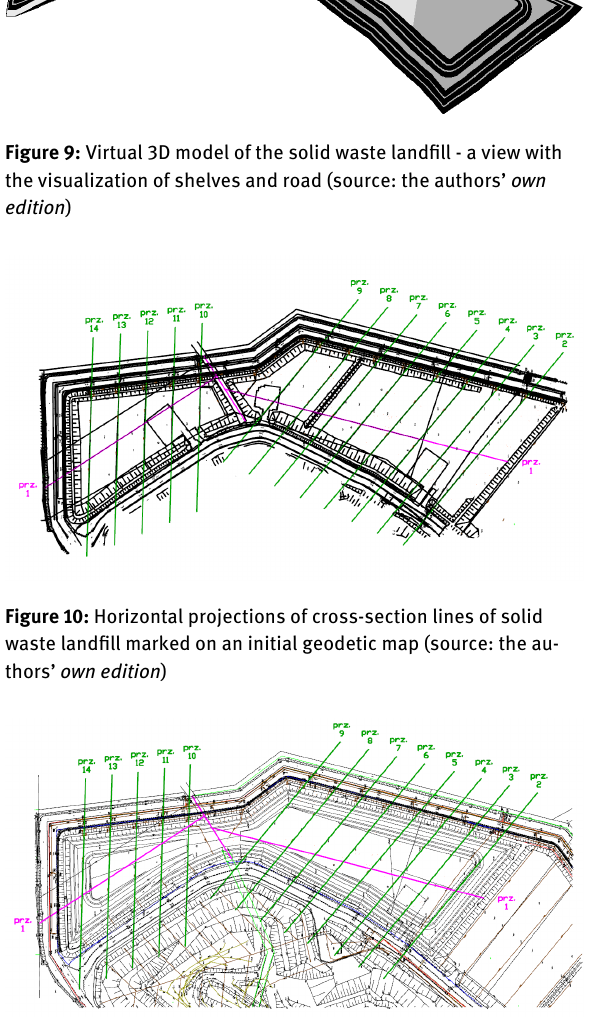
Figure 11: Horizontal projection (top view) of the location of section lines of the solid waste landfill plotted on a 3D model view (source: the authors’ own edition